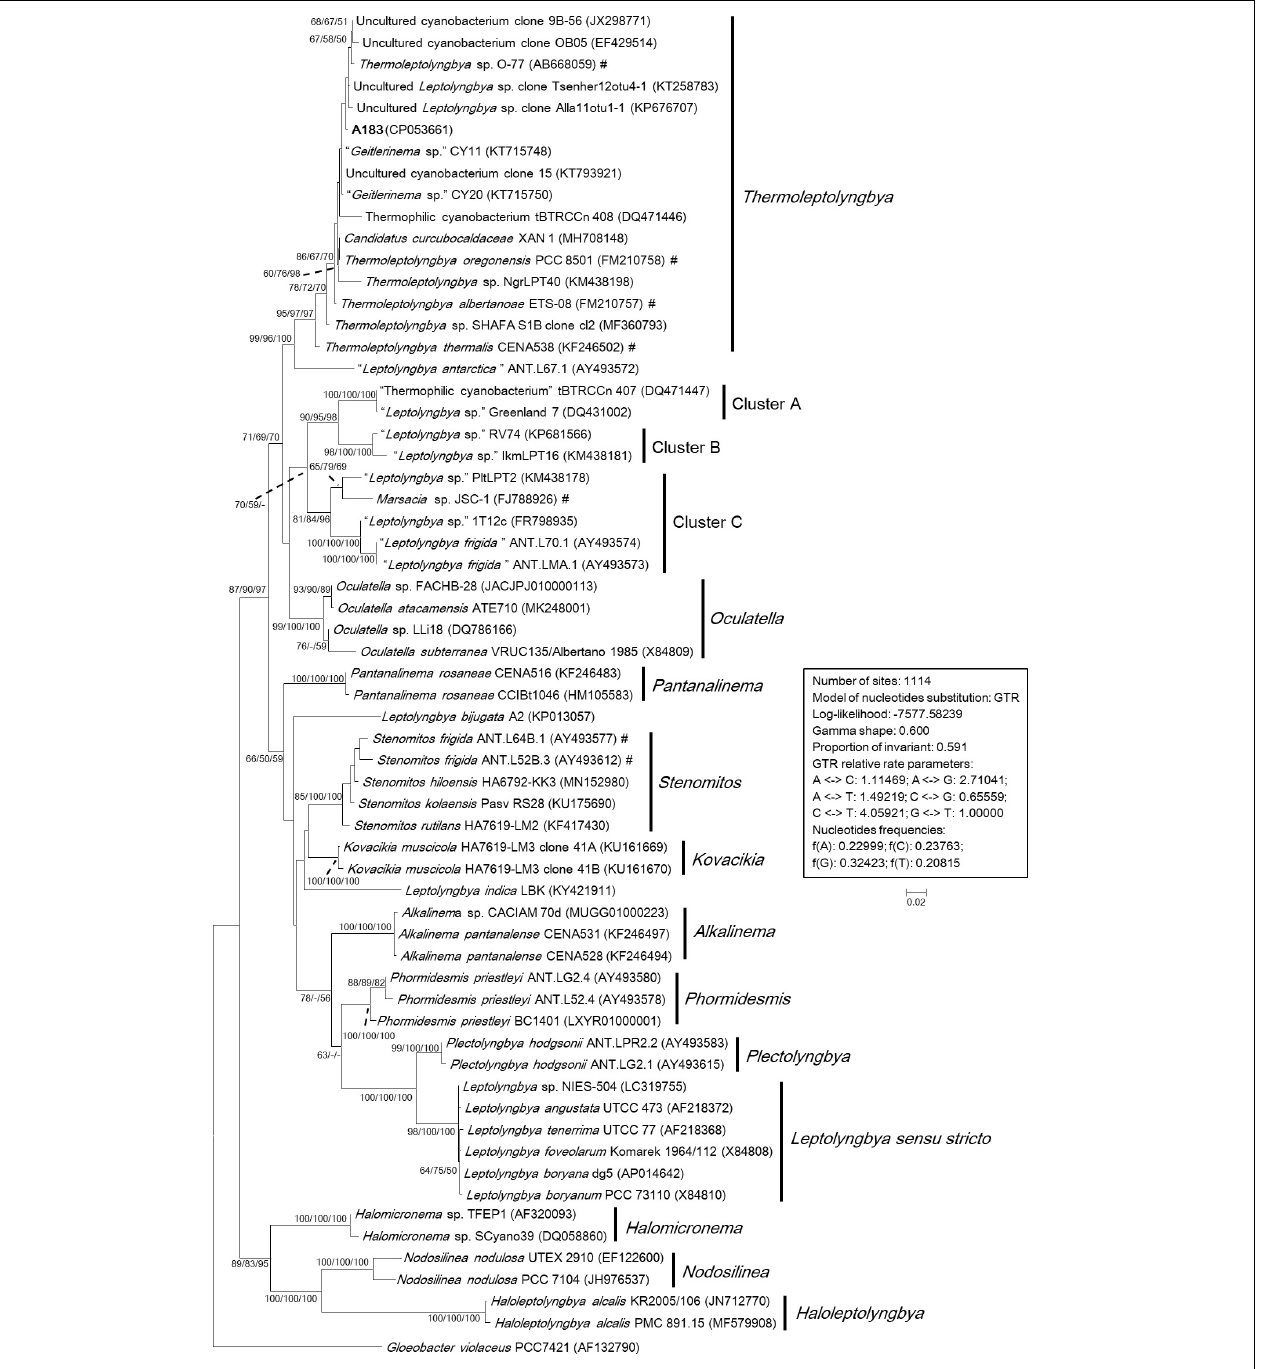
FIGURE 3 | Maximum-likelihood phylogenetic tree of 16S rRNA gene sequences. The numbers at nodes refers to the support values of ML, MP, and NJ analysis, respectively. Only bootstrap values > 50% (1000 non-parametric replications) are indicated at nodes. Genera or cluster are indicated by vertical bars. Scale bar = 2% substitutions per site. Strains in quotation marks have uncertain genus names. Strains marked with # have been recently reclassified or proposed to be reclassified.